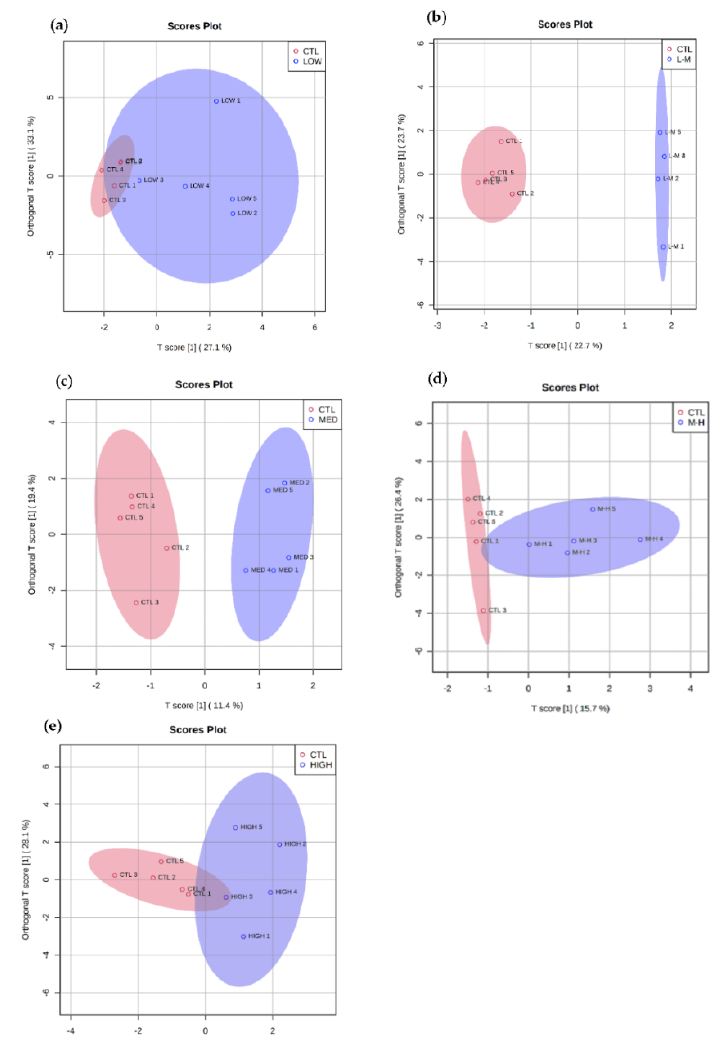
Figure 2. Orthogonal PLS-DA of polar metabolites from amphipods exposed to PFOS (blue) and control (pink) for 7 days at ( a ) low (0.04 µg/L), ( b ) low – medium (0.20 µg/L), ( c ) medium (1.00 µg/L), ( d ) medium – high (5.00 µg/L) and ( e ) high (25.00 µg/L) concentrations. Orthogonal PLS-DA model validation data can be found in Supplementary Materials (Figures S1 – S5).